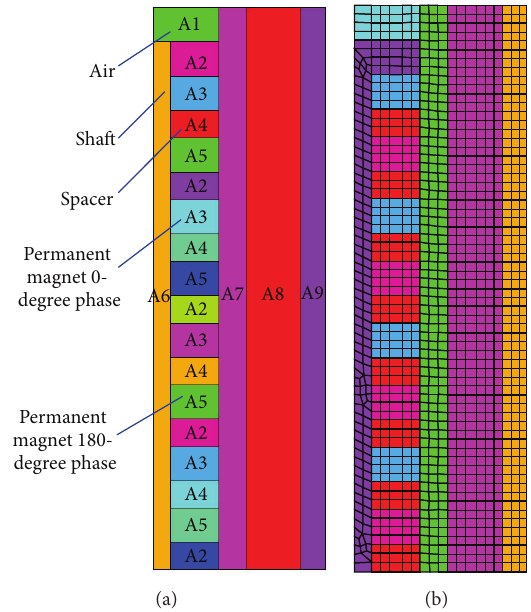
Figure 7: Modelling of the linear power generator: (a) entity model and (b) finite element